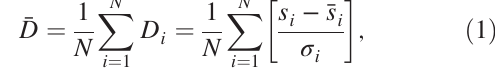
¯ D as defined in ¯ D is shown